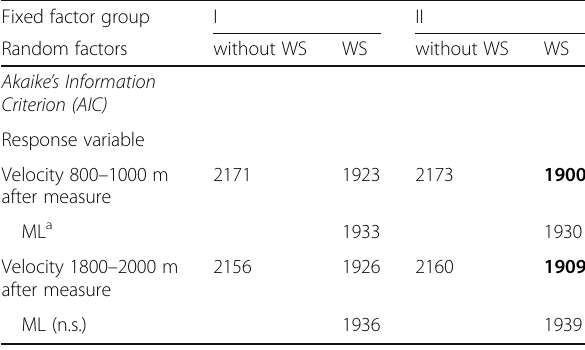
Table 3 Selection of the models based on Akaike ’ s information criterion (AIC) for the two components of random factor effects and fixed factor effects and the linear regression models and the LME models